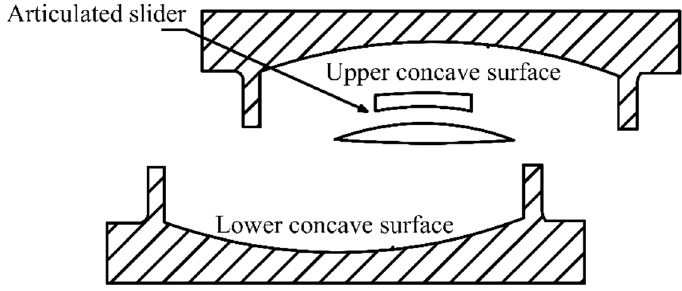
Figure 4. Schematics of a double pendulum friction bearing.